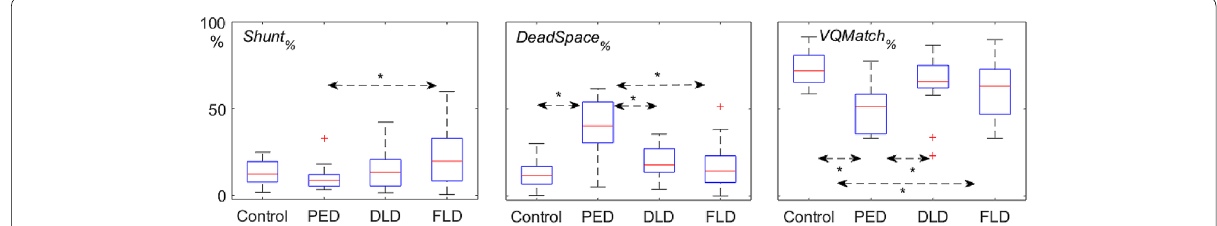
Fig. 3 Comparisons of Shunt % , DeadSpace % , VQMatch % in the four groups. The control group was postoperative ICU patients without acute respiratory failure; PED group: patients with pulmonary embolism-related disease; DLD group: patients with diffuse lung involvement disease; FLD group: patients with focal lung involvement disease. The boxes mark the quartiles with median marked red, while the whiskers extend from the box out to the most extreme data value within 1.5 * the interquartile range of the sample. The red crosses are outliers.* P < 0.05